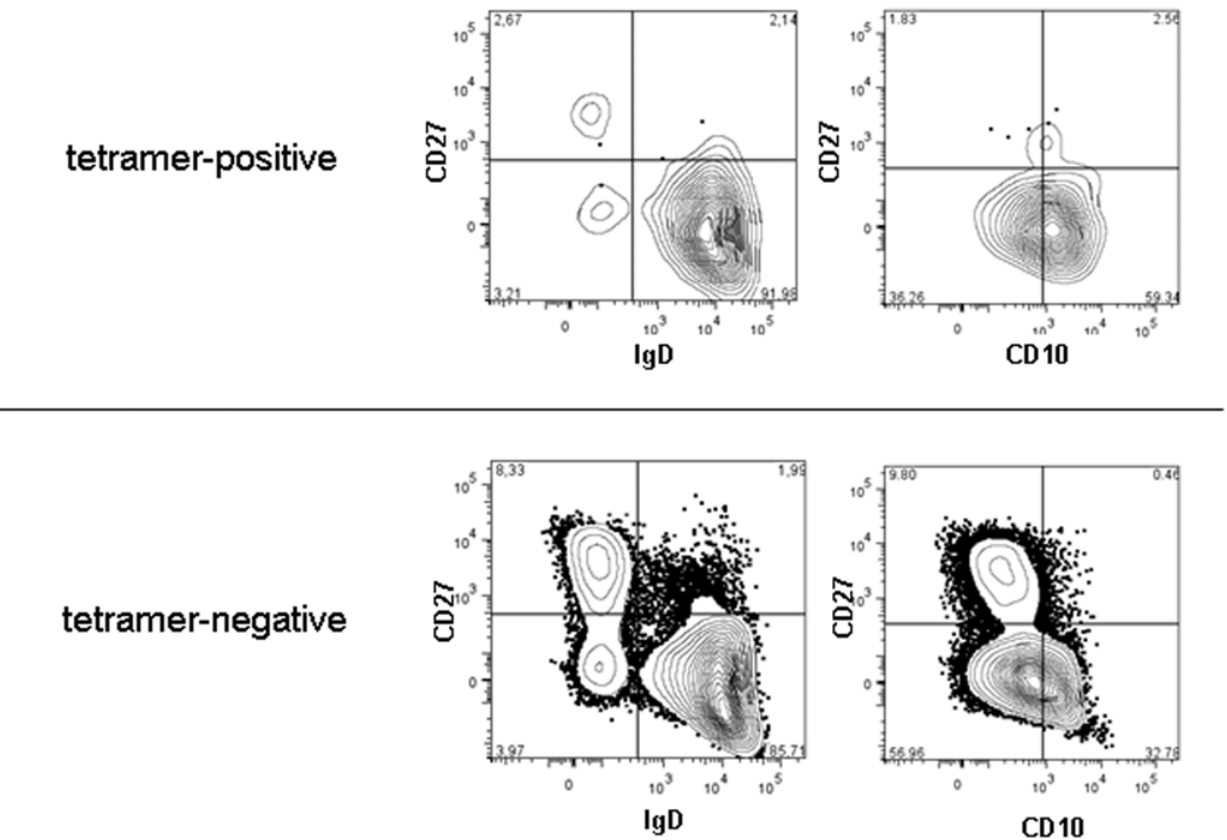
Figure 3. Gating strategy used to characterize tetramer-binding B cells further. In addition to the gating procedure depicted in Figure 2A, tetramer-binding and tetramer-negative B cells were subdivided in CD27 + memory B cells and CD27 ++ plasmablasts (antigen-experienced) and CD27 2 IgD + antigen-inexperienced B cells, comprising both transitional (CD10 + ) and naı¨ve (CD10 2 ) B cells.